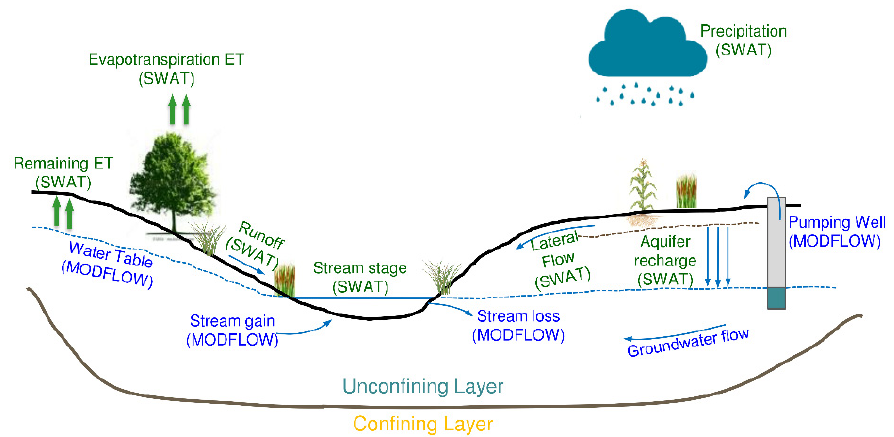
Figure 5. Schematic representation of conceptual water balance of coupled SWAT MODFLOW model [9,38,39].